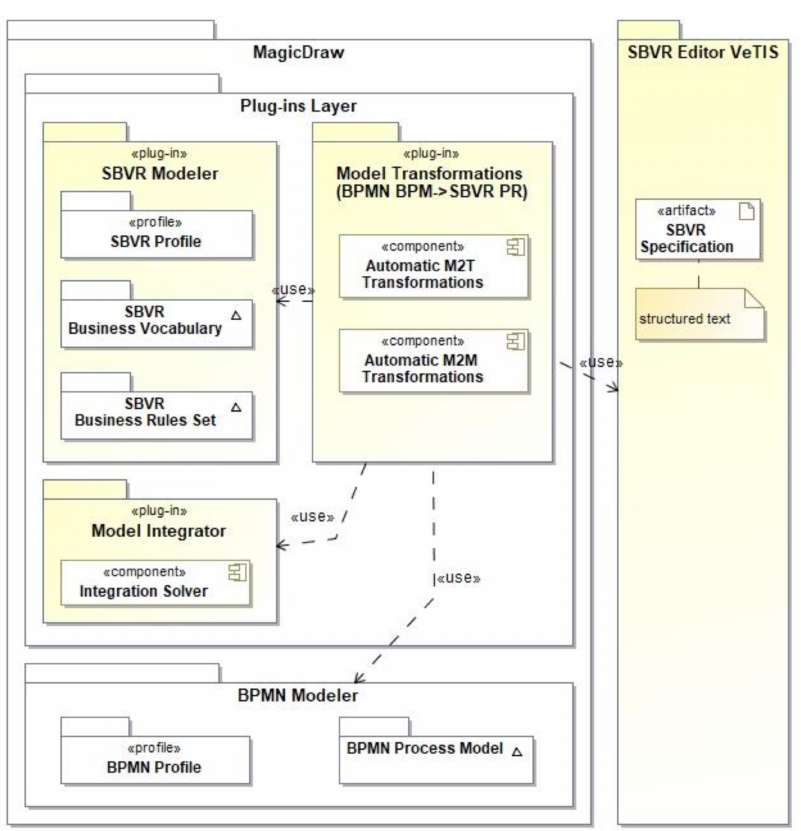
Figure 2. The basic architecture of the prototype of the model transformation